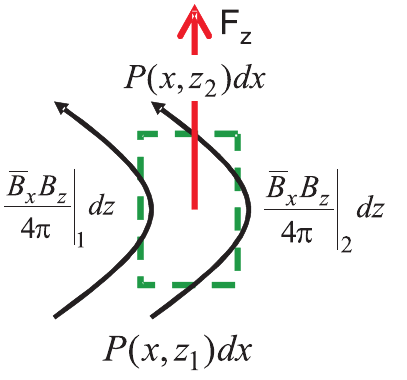
Fig. 1. Displacement of a small element of the current